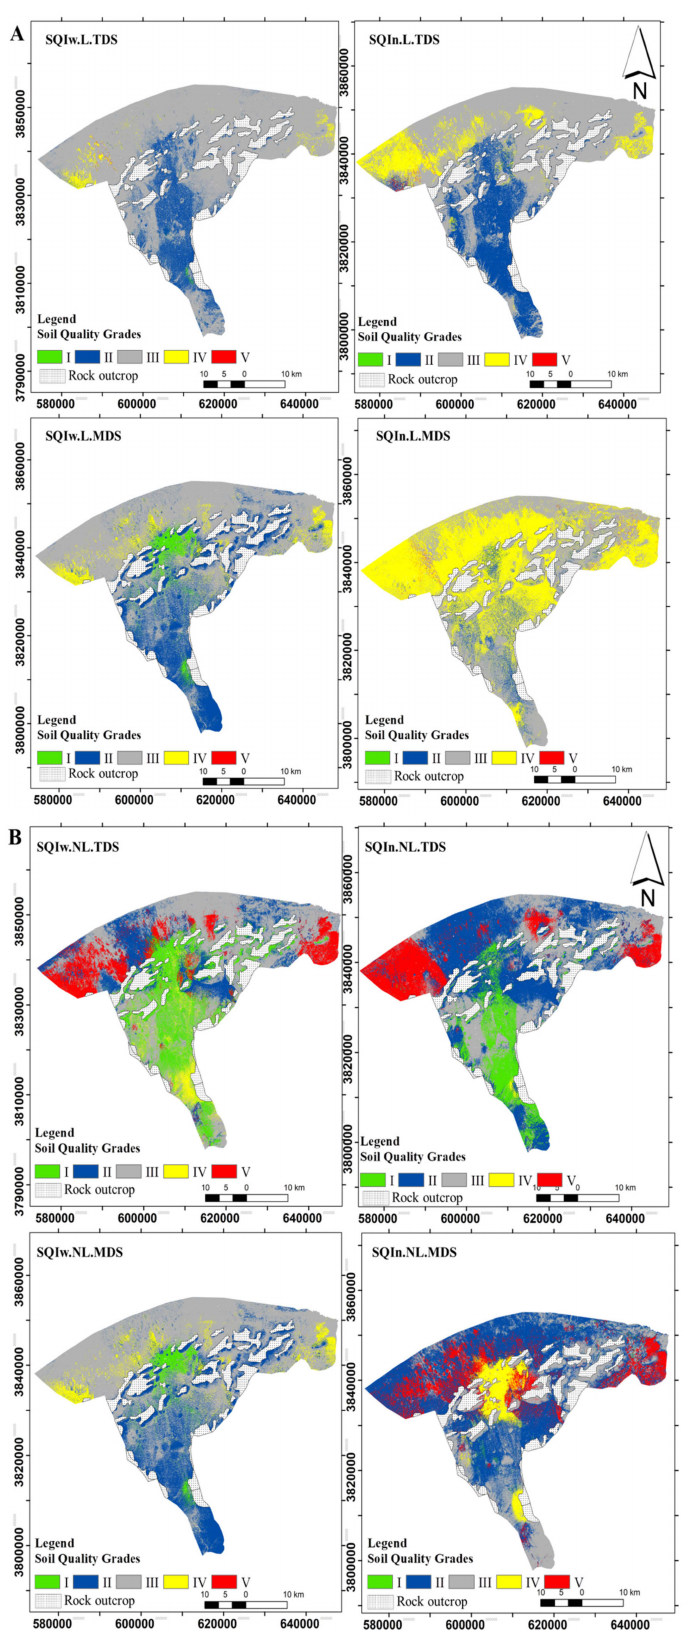
Figure 3. Soil quality grades distribution for different soil quality indices ( SQI w —weighted additive soil quality index SQIs ; SQI n —nemoro soil quality index; TDS—total data set; MDS—minimum data set) with ( A ) linear scoring and ( B ) nonlinear scoring